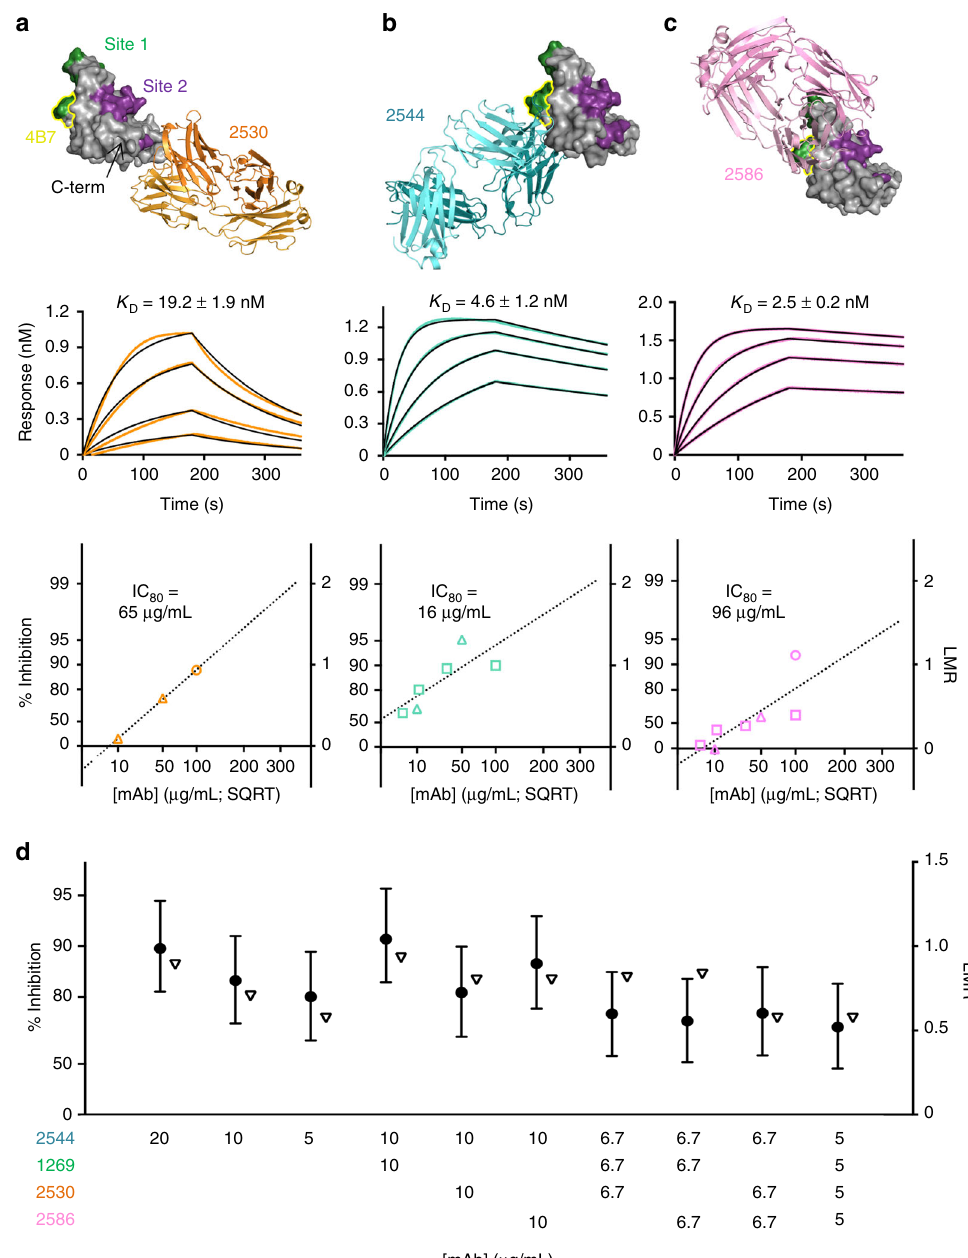
Fig. 3 Structure – function characterization of human antibodies against Pfs25. Top: crystal structure of Pfs25 in complex with 2530 Fab ( a , orange), 2544 Fab ( b , teal), and 2586 Fab ( c , pink). Site 1 (green), Site 2 (purple), the C terminus, and the 4B7 loop (yellow outline) are denoted in a . Middle: representative kinetic curves of 2530 Fab ( a ), 2544 Fab ( b ), and 2586 Fab ( c ) binding to Pfs25, as measured by BLI, showing association and dissociation when Pfs25 is immobilized on Ni-NTA biosensors and associated with serially diluted Fab (500 – 15.6 nM concentrations). The K D is indicated and derives from three replicates with error de fi ned as standard deviation. Bottom: SMFA of 2530 IgG ( a ), 2544 IgG ( b ), and 2586 IgG ( c ) at various concentrations across two feeds. Percentage of inhibition is plotted along the left y -axis, log of mean oocyst reduction (LMR) is plotted along the right y -axis. Shapes represent different SMFA feeds, and reported IC 80 is calculated from the plotted line of best fi t. d Combinatorial SMFA, plotted as above. Concentrations of the mAbs used are depicted along x -axis, and all combinations tested were at a cumulative mAb concentration of 20 µ g/mL. Circles depict the best estimate of SMFA inhibition for each mAb from two feeding experiments, while upside-down triangles refer to expected inhibition. For combinatorial SMFA, expected inhibition was calculated using the Bliss independence model. Error bars are 95% con fi dence